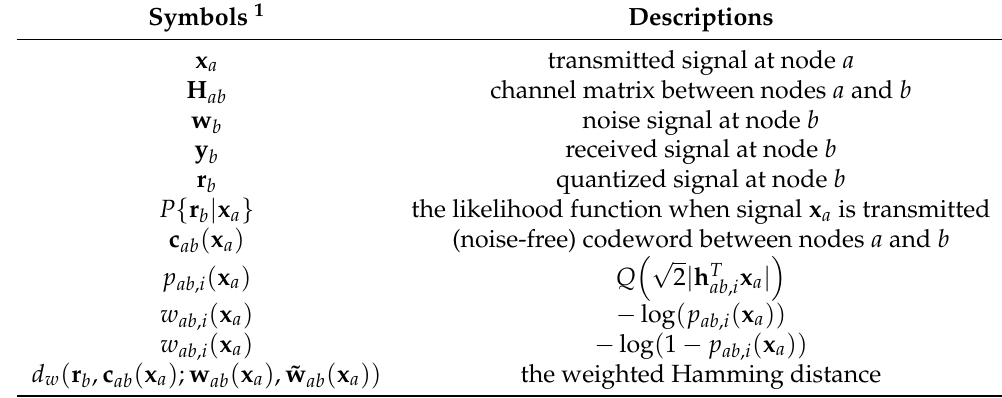
Table 2. Representative symbols in this study.